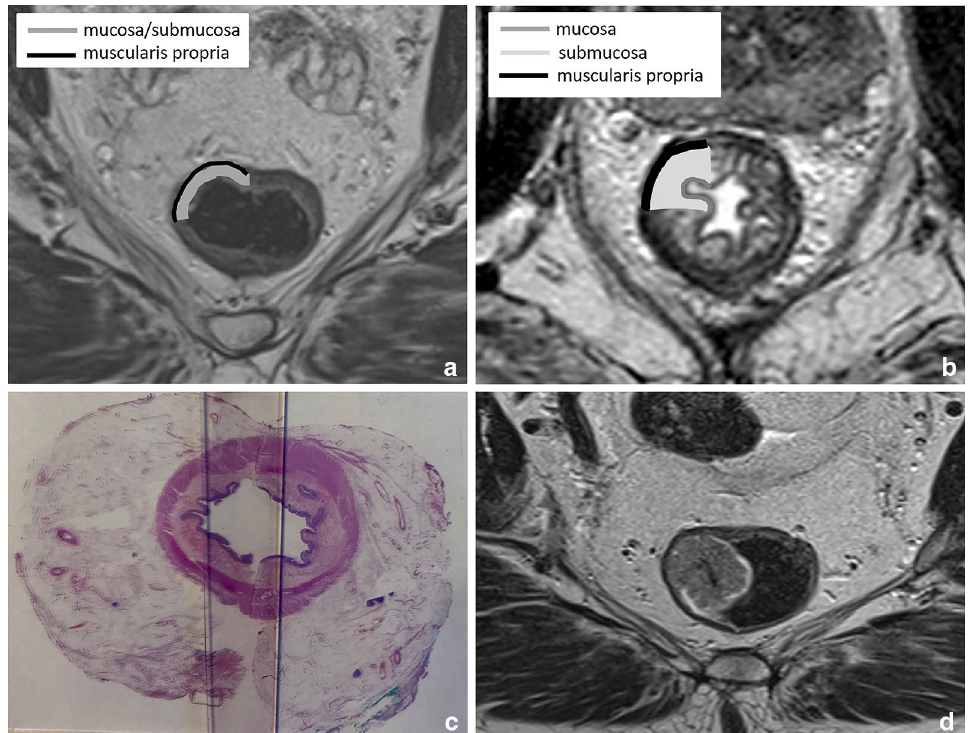
Fig. 2 Examples showing the normal two‑layered ( a ) versus oedematous three‑layered ( b ) appearance of the rectal wall on axial T2‑weighted MRI and the corresponding cross‑sectional wall anatomy at histopathology ( c ). Figure d shows an example of a 63‑year‑old male rectal cancer patient with a polypoid tumour staged as cT1‑2 considering that the submucosa is not separately visible, making it impossible to determine whether this tumour invades the submucosa (T1) or infiltrates the muscularis propria